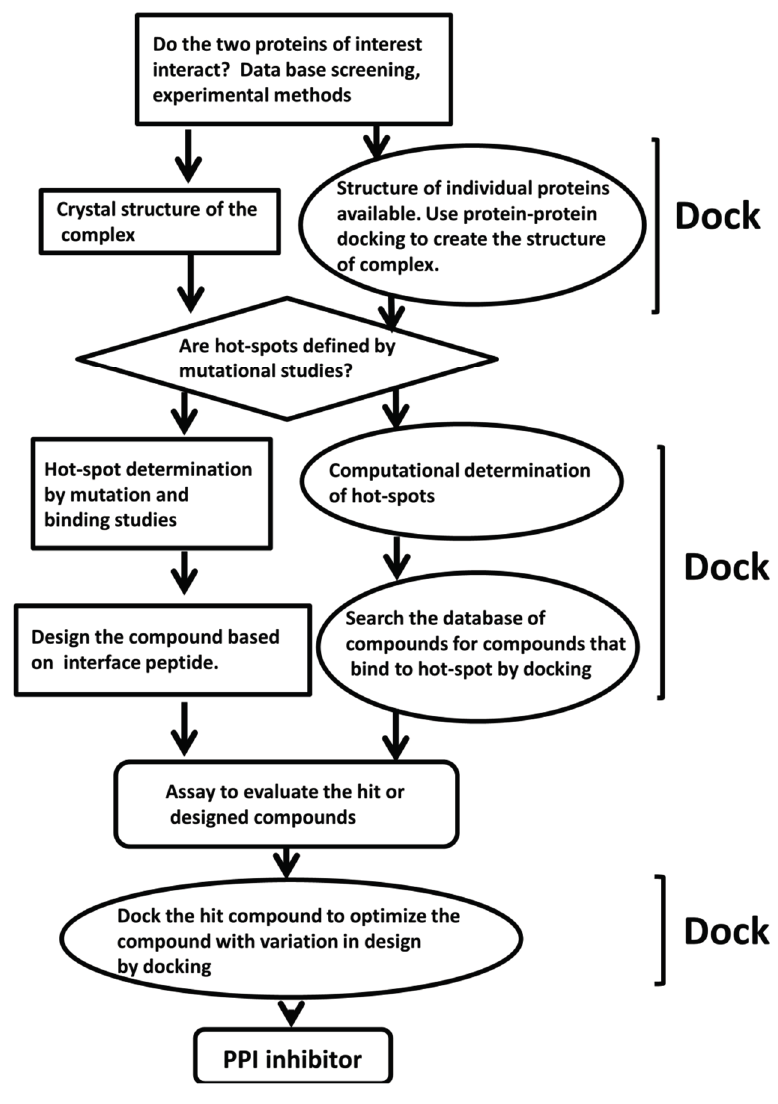
Figure 1. A schematic diagram for the design of PPI inhibitors and docking methods used at different stages of the